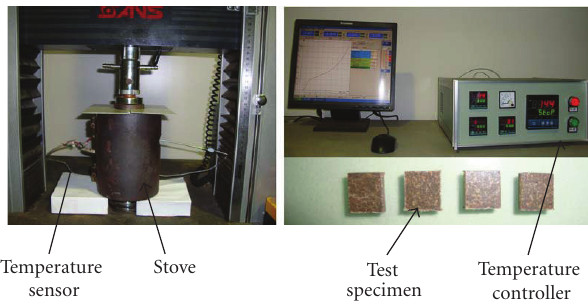
Figure 1: Thermo-compression test for PP wood